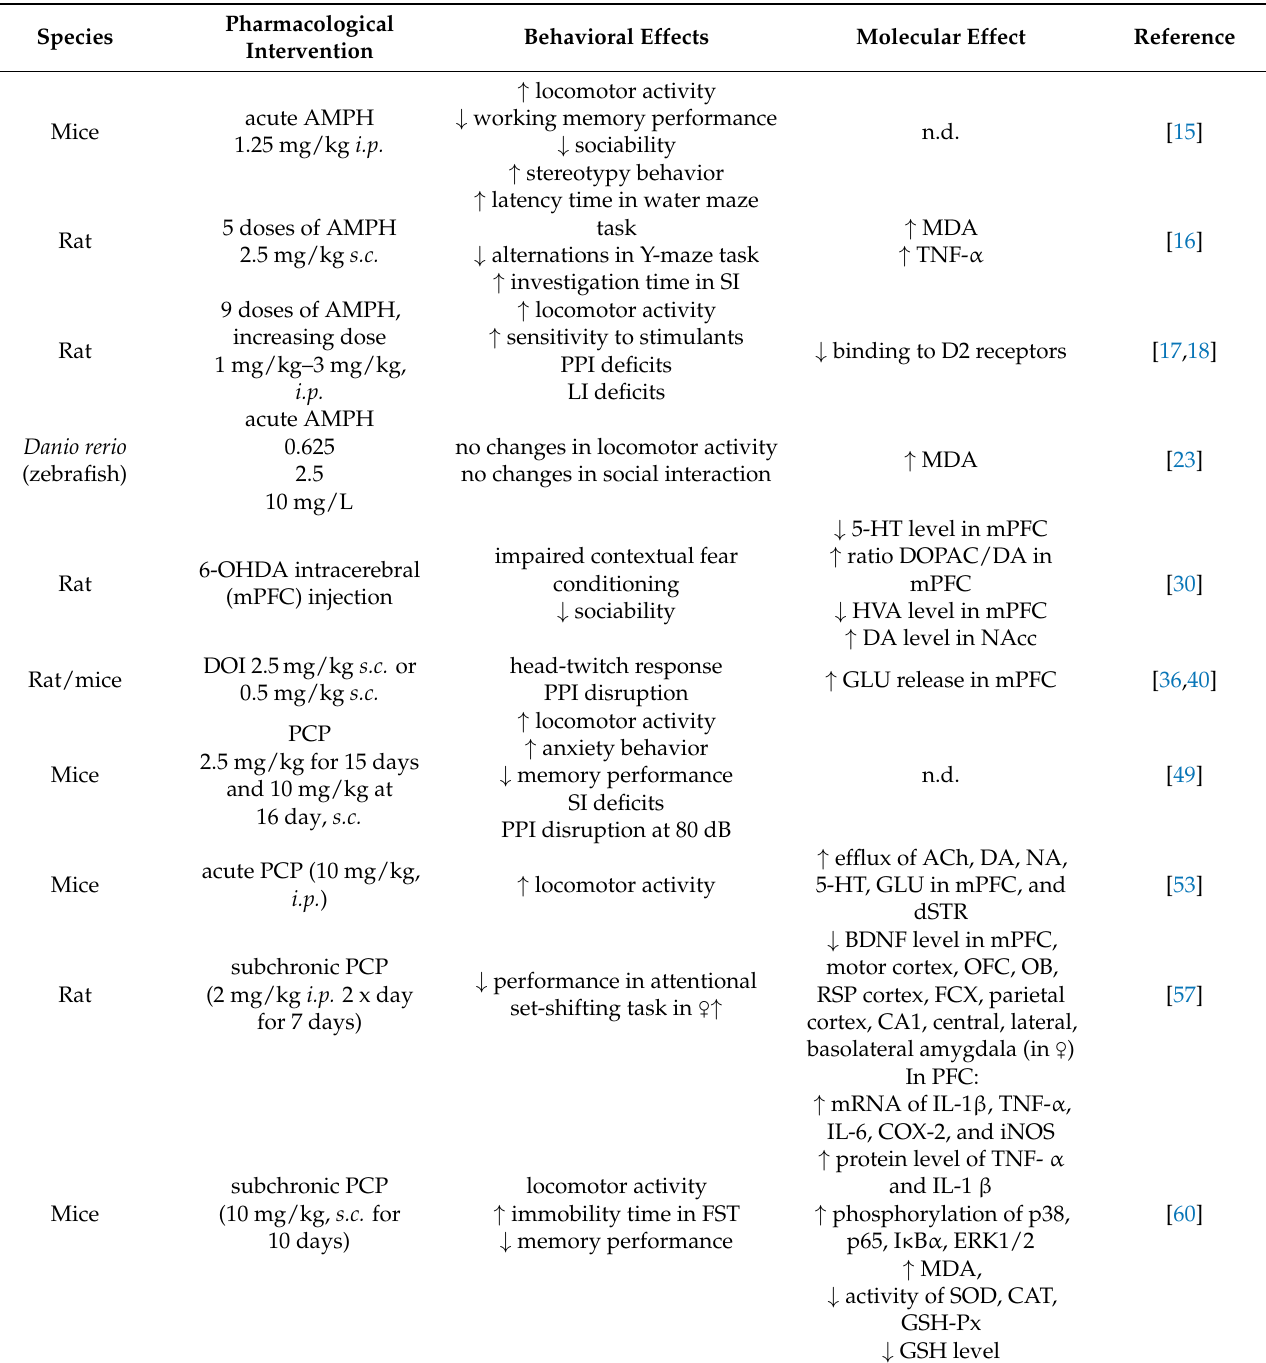
Table 1. Several examples of pharmacological intervention and its behavioral and molecular